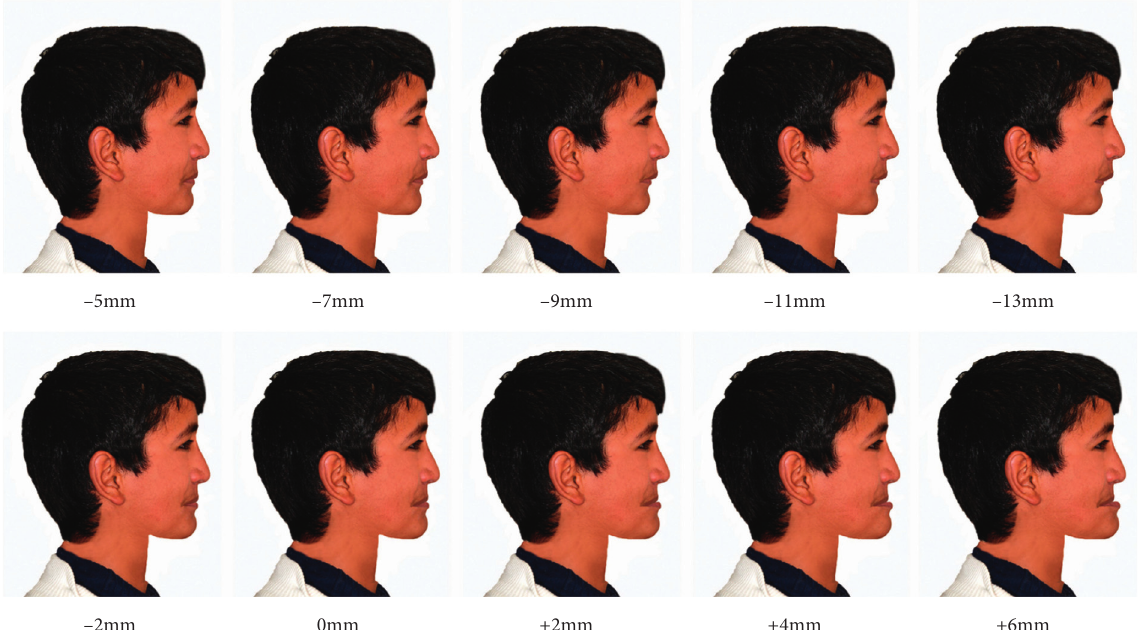
Figure 3: The manipulated profile images to affect mandibular retrusion and protrusion based on relation of the Pog ∗ point to the